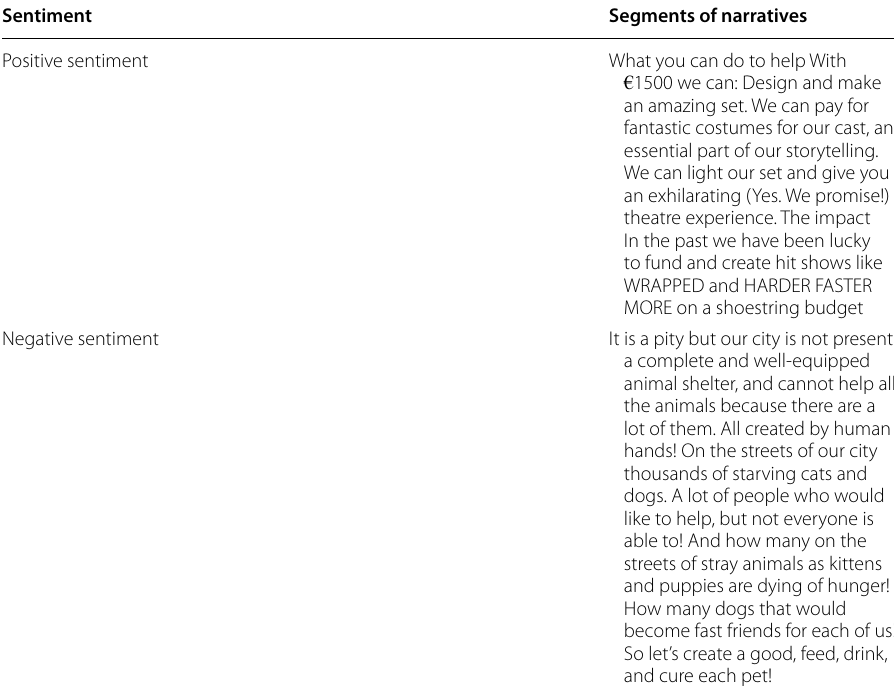
Table 4 Samples of sentimental cues Sentiment Segments of